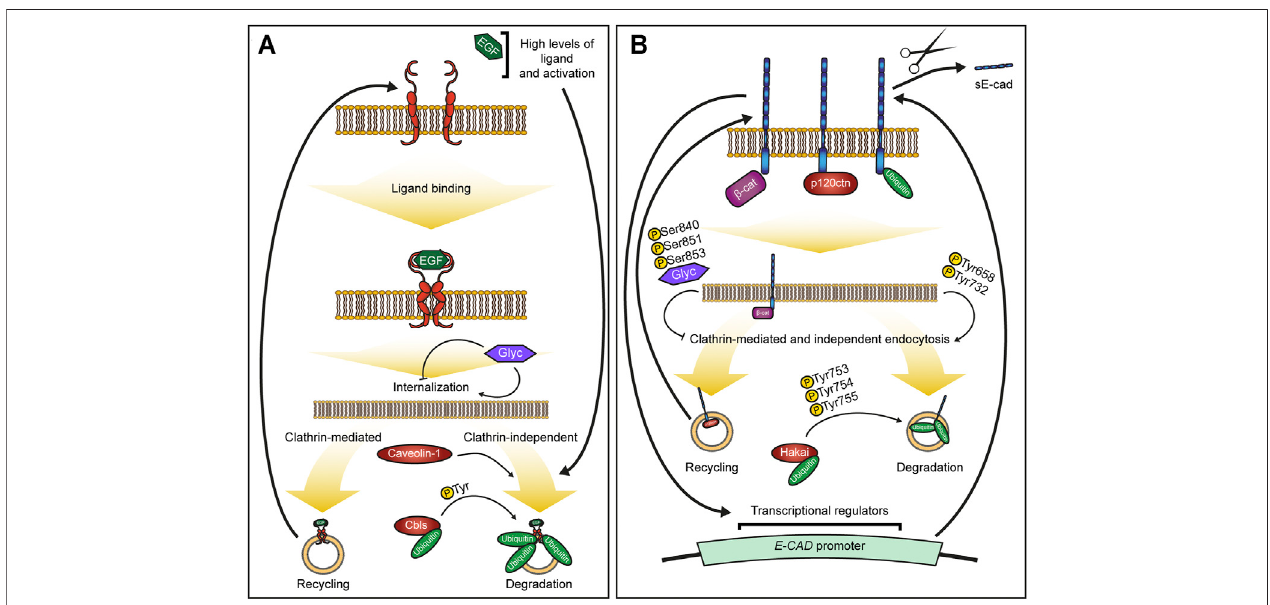
FIGURE1| Overviewofmechanisms controllingEGFRandE-cadherinendocytosis. (A,B) – SummaryofEGFR (A) andE-cadherin (B) regulation.Ligand-induced activation and dimerization of EGFR (A) trigger endocytosis of the receptor. The clathrin-mediated endocytosis is followed by recycling of the receptor and comprises most of the endocytic events, whereas clathrin-independent endocytosis, including caveolae, leads to EGFR degradation and is promoted upon a certain threshold of EGFR activation. Ubiquitination by Cbls ubiquitin ligases serves as a key cue for EGFR degradation and is modulated by EGFR phosphorylation. Levels of E-cadherin at the plasma membrane (B) are regulated by endocytosis, which is modulated by E-cadherin interactions with its binding partners. β -catenin ( β -cat) helps retain E-cadherin at the membrane, whereas p120-catenin (p120ctn) prevents E-cadherin endocytosis for degradation but promotes its recycling. Both clathrin- mediated and independent pathways can be followed byeither E-cadherin recycling or degradation, but the latter depends on E-cadherin ubiquitination bythe ubiquitin ligase Hakai and potentially others. E-cadherin membrane presentation also regulates own gene ( E-CAD ) expression. Dynamics of both E-cadherin and EGFR is also regulated by glycosylation of their extracellular